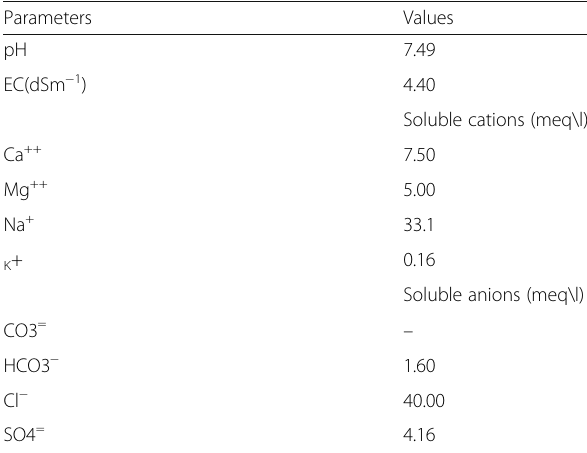
Table 2 Chemical characteristics of water weal used for the present